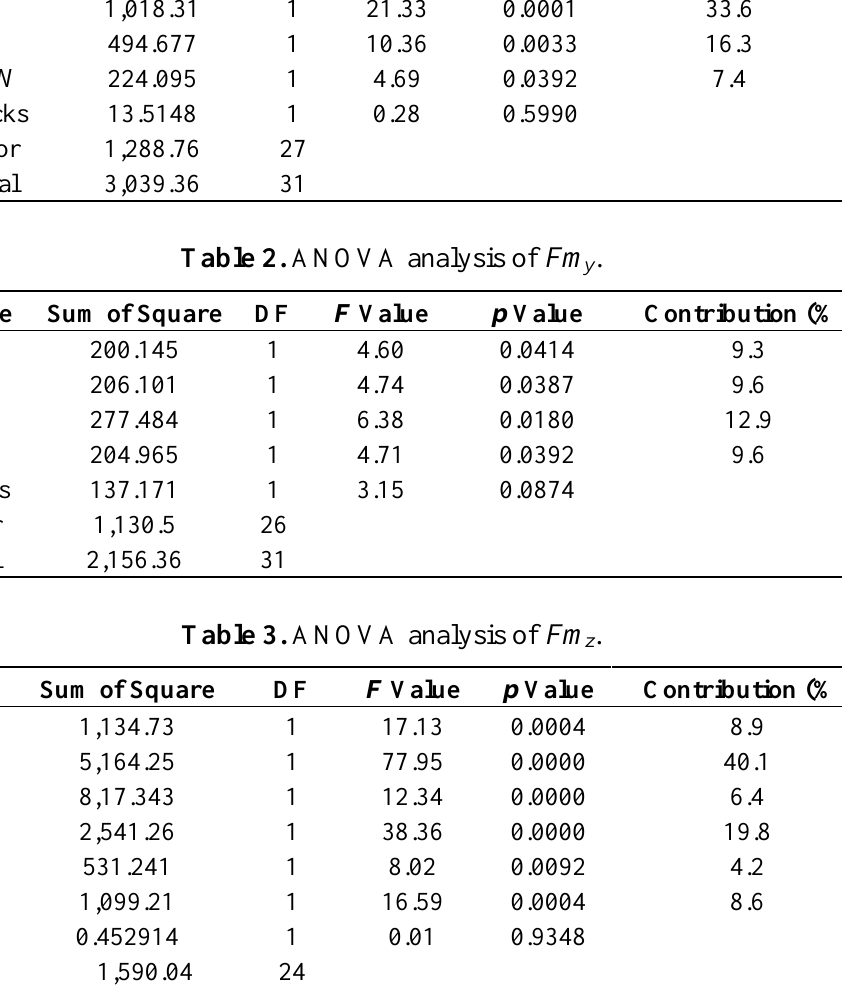
Table 1. ANOVA analysis of Fm